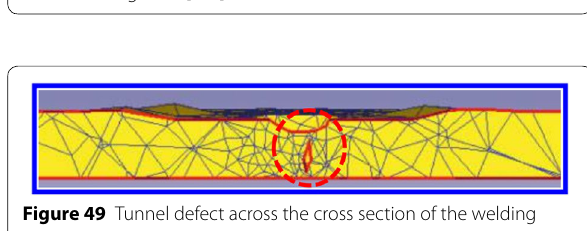
Figure 49 Tunnel defect across the cross section of the welding